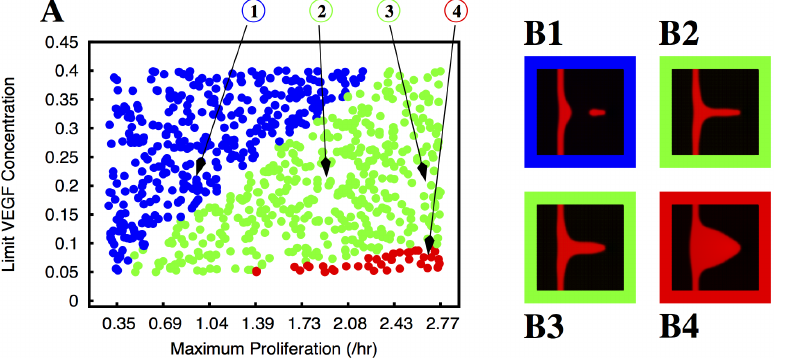
Fig 7. Morphology of the growing sprouts with endothelial cell proliferation dependent on VEGF concentration but triggered by local strain. In plate A we indicate the morphology of the growing sprout (by using different colours) for different values of maximum proliferation ( M P ) and limit VEGF concentration ( L V ). In these simulations the proliferation rate increases linearly with the VEGF concentration until it reaches its maximum value M P at the concentration L V , but is only different from zero where the strain is larger than a cut- off S m = 0.05. The colours indicate the morphology of the observed sprouts for the corresponding parameters: blue dots correspond to situations where the sprout breaks, the green dots correspond to well formed sprouts without appreciable thickening of the parental vessel, and the red dots correspond to deformed vessels (i.e. triangular sprouts). We observe that the sprout breaks for low proliferation rates, but there is a very large region of the parameter space with well formed sprouts. In plates B1, B2, B3 and B4 we plot examples of the morphologies observed (the color of the border in these plates follows the same code as in plate A). The parameters used to obtain the morphologies depicted in B1, B2, B3 and B4 are indicated by arrows in plate